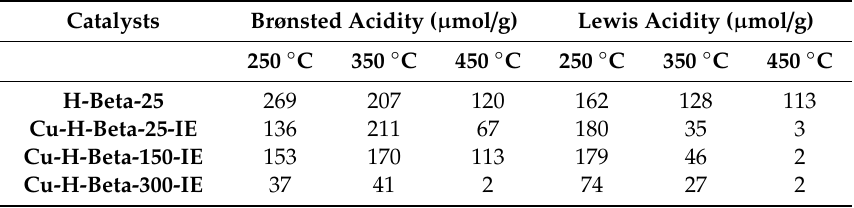
Table 5. Brønsted and Lewis acidities of the proton and Cu modified Beta zeolites